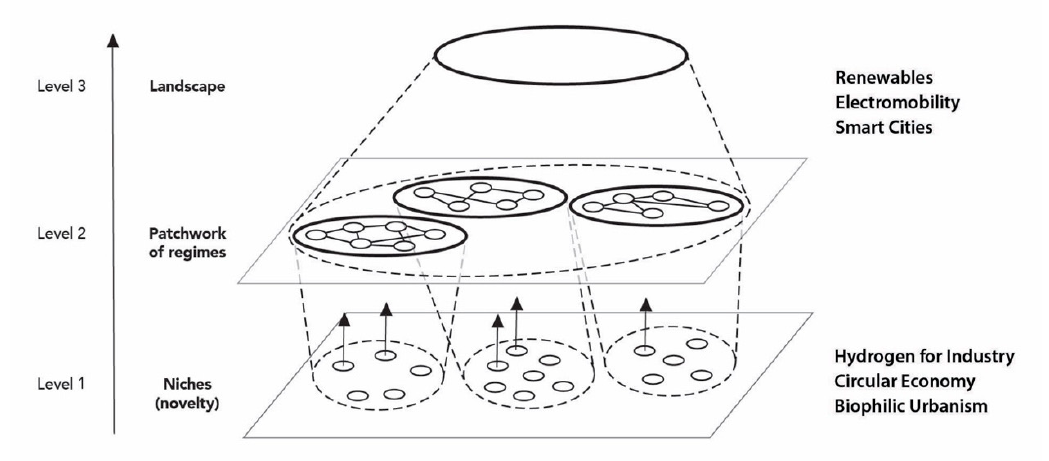
Figure 3. Multilevel perspectives on innovations. Source: Redrawn from Geels et al. [17–20].